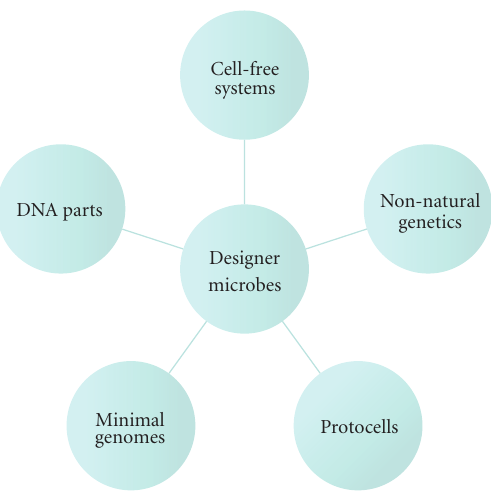
Figure 3: Convergence of the di ff erent realms of synthetic biology. In addition to e ff orts to refine and characterize genetic parts based on DNA, research on expanding the genetic code and implementing biological processes in cell-free systems will likely integrate with metabolic engineering projects in the future. Genome engineering and synthetic genomics will enable the manufacture of customiz- able minimal genomes. Alternatively, protocell engineering may provide a non-biological chassis to house synthetic